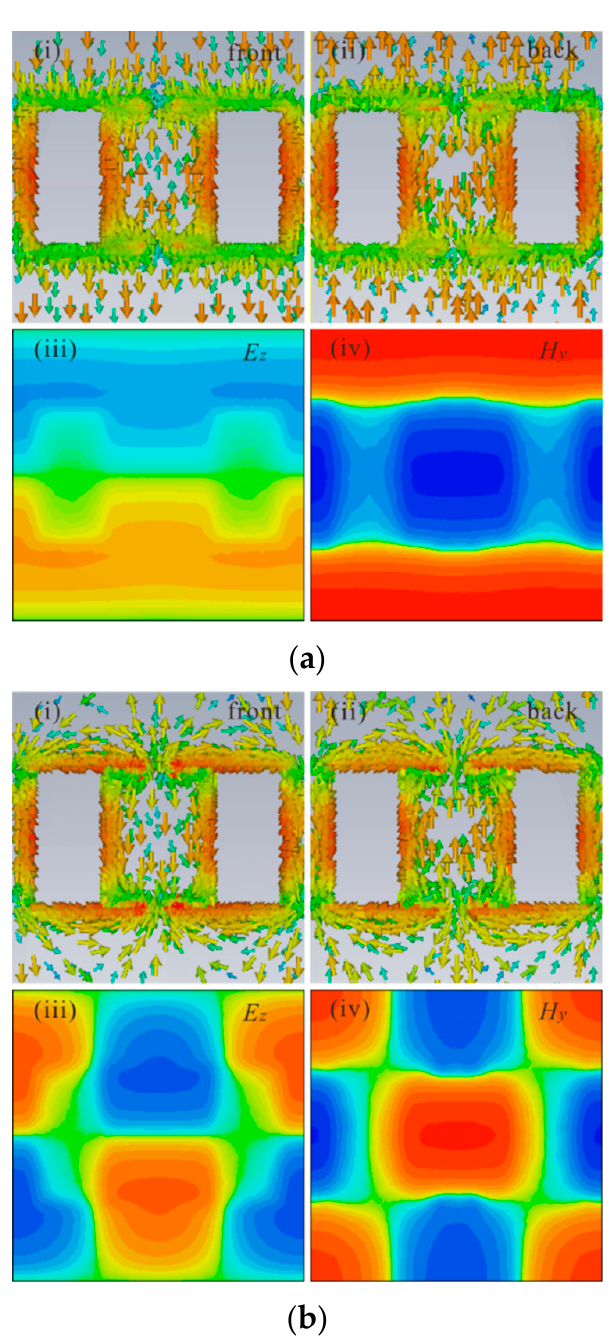
Figure 3. Surface current distributions on the (i) front and (ii) back metal slabs, and field distributions (iii) E z and (iv) H y at xy-plane located in the middle dielectric between the front and back metal slabs of LHMs’ unit cell for ( a ) 2.35 terahertz (THz) and ( b ) 3.06 THz. For the second peak of transmission coefficient in Figure 2a, which appears at 3.06 THz, the front/back surface current distributions, E z and H y , is demonstrated in Figure 3(bi–biv). Similar to the results of 2.35 THz of Figure 3a, the current loop and magnetic resonance can be offered. However, the details of the distributions in Figure 3b are different than those in Figure 3a, and the surface currents on the h 1 regions and the corners of the h 2 regions are anti-paralleled to those on the other regions, indicating different LHMs